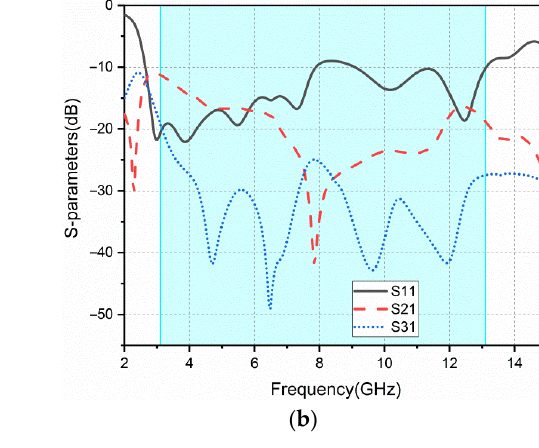
Figure 4. ant4: ( a ) geometry; ( b ) S-parameters.